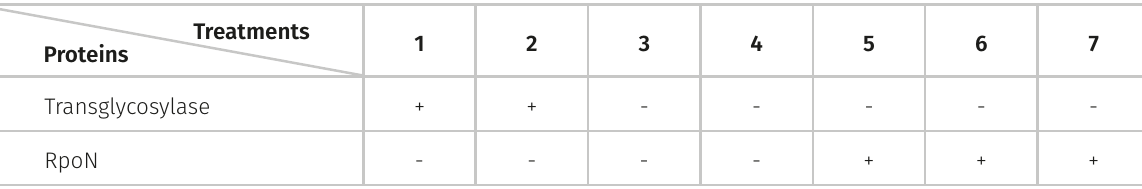
Table IV. Analysis of expression (+) and suppression (-) of transglycosylase and RpoN proteins against different antimicrobial treatments in P. aeruginosa JX05 isolate by MALDI-TOF